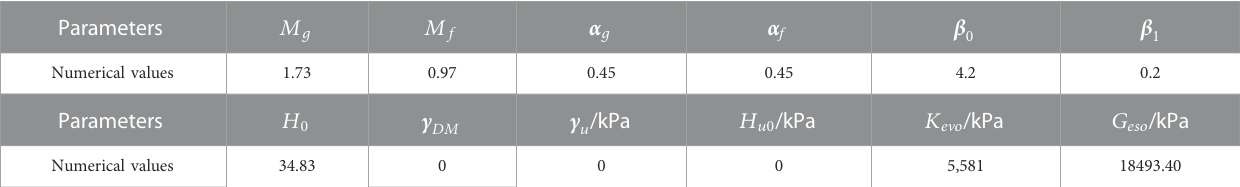
TABLE 10 Parameters of the P-Z constitutive model for coarse-grained materials.